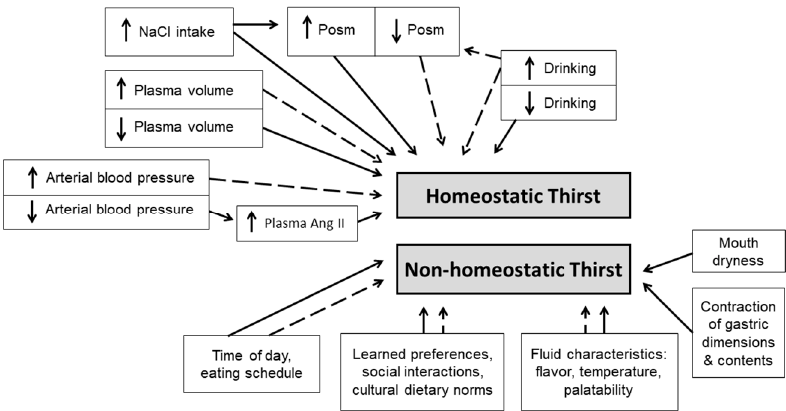
Figure 3. Factors that influence thirst are categorized as either homeostatic (i.e., volume, pressure, concentration) or relatively rapid non-homeostatic (anticipatory) inputs. Solid and dashed arrows represent, respectively, factors that increase and decrease thirst. Abbreviations: NaCl, sodium chloride; Posm, plasma osmolality; Ang II, angiotensin II.